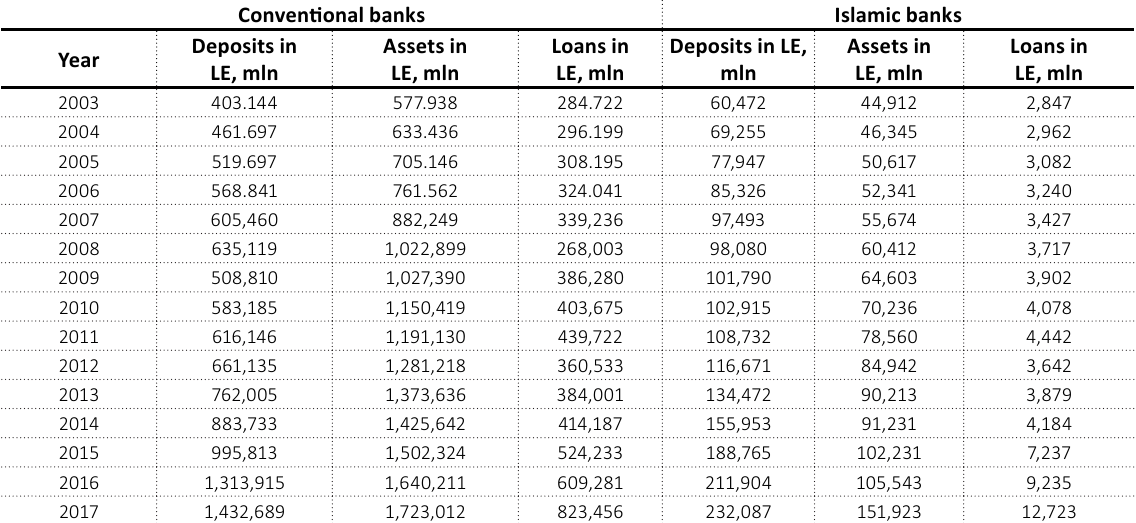
Table 1. Total assets, deposits and loans for the years 2003 to